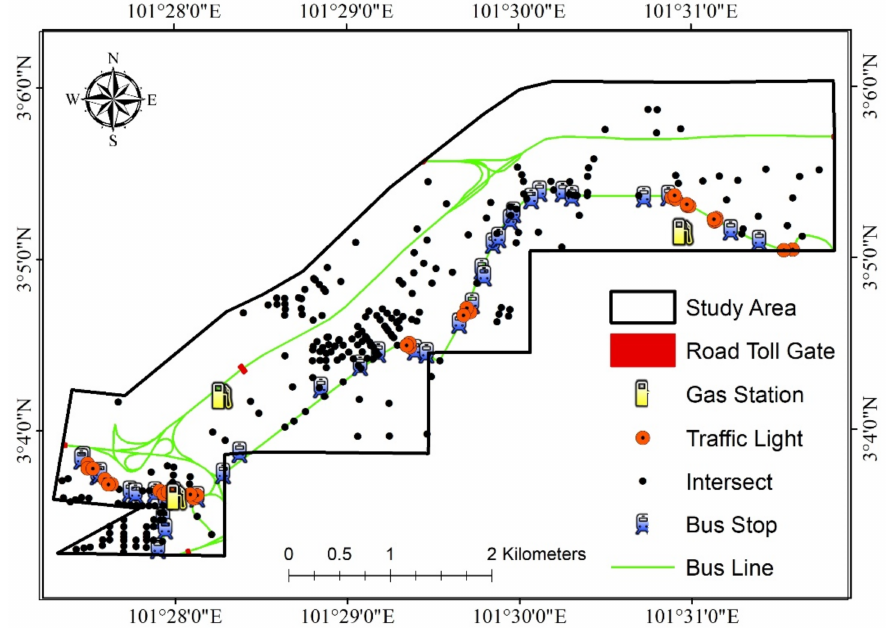
Figure 6. Road toll gate, gas station, traffic light, intersect, bus stop, and bus line.